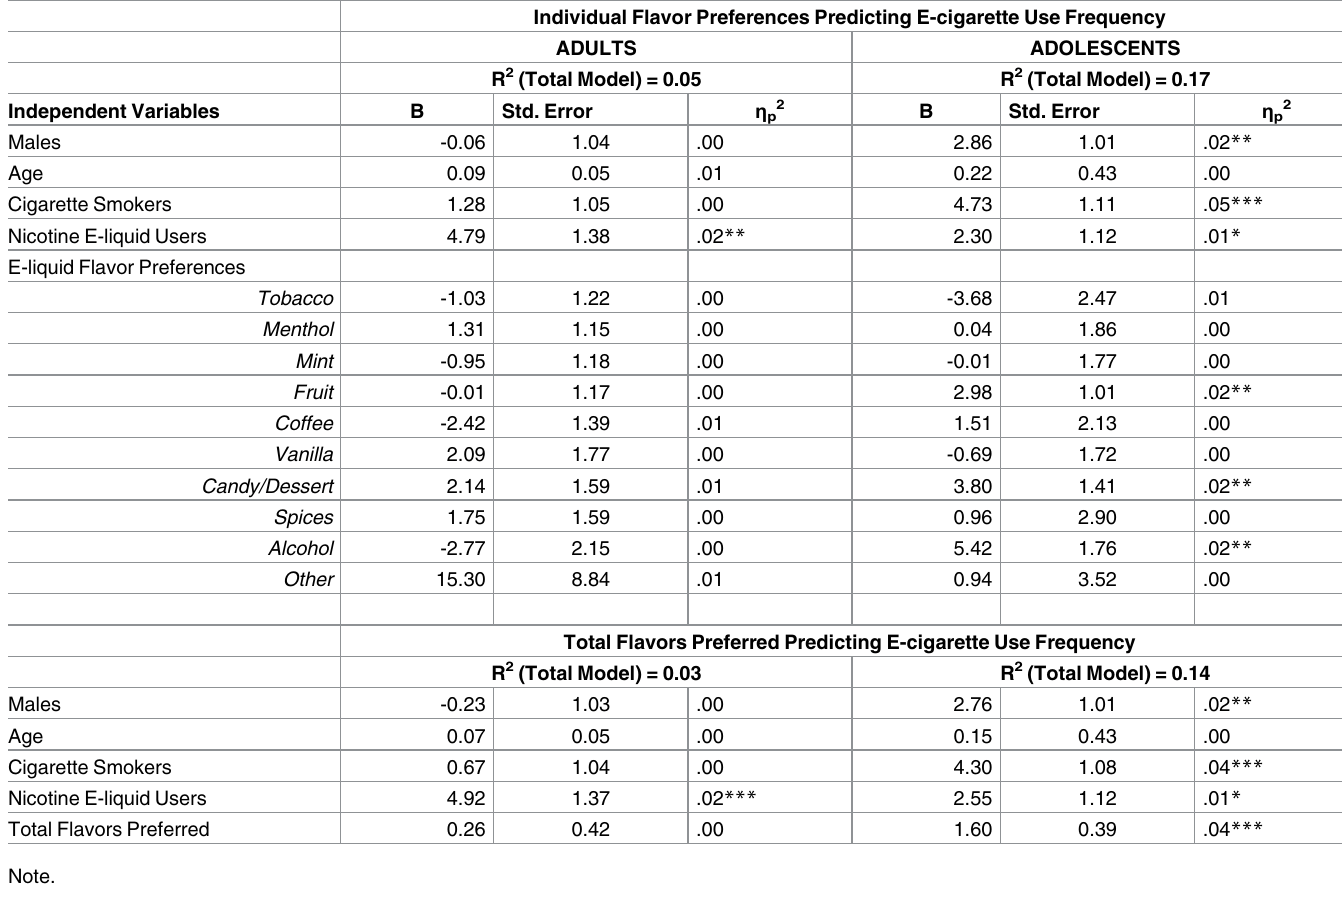
Table 2. Predictors of e-cigarette use frequency in adults and